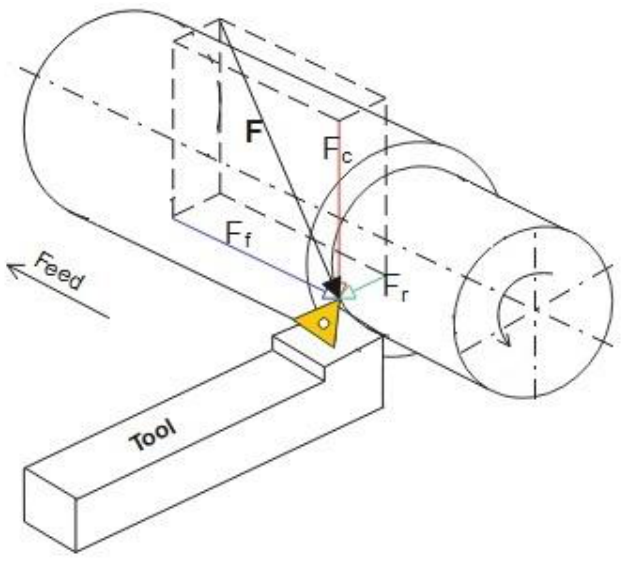
Figure 1. Cutting force components in the turning process, where F is resultant cutting force, F c tangential force, F r radial force, and F f feed force.